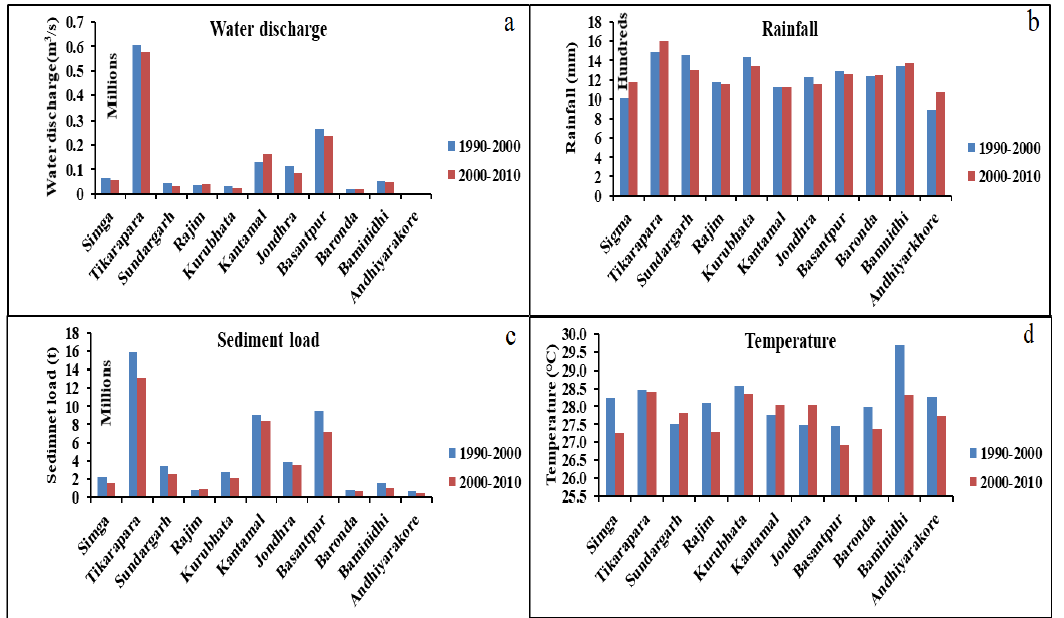
Figure 4. Comparative analysis of long-term variation over the past two decades of ( a ) WD, ( b ) RF, ( c ) SL, and ( d ) T.